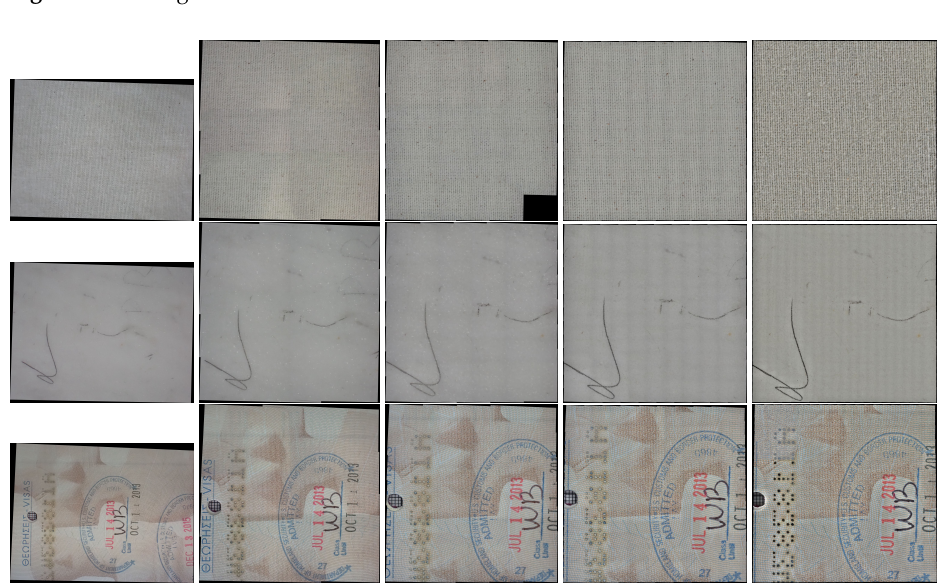
Figure 10. Canvas, handwritten paper, and passport with stamp and